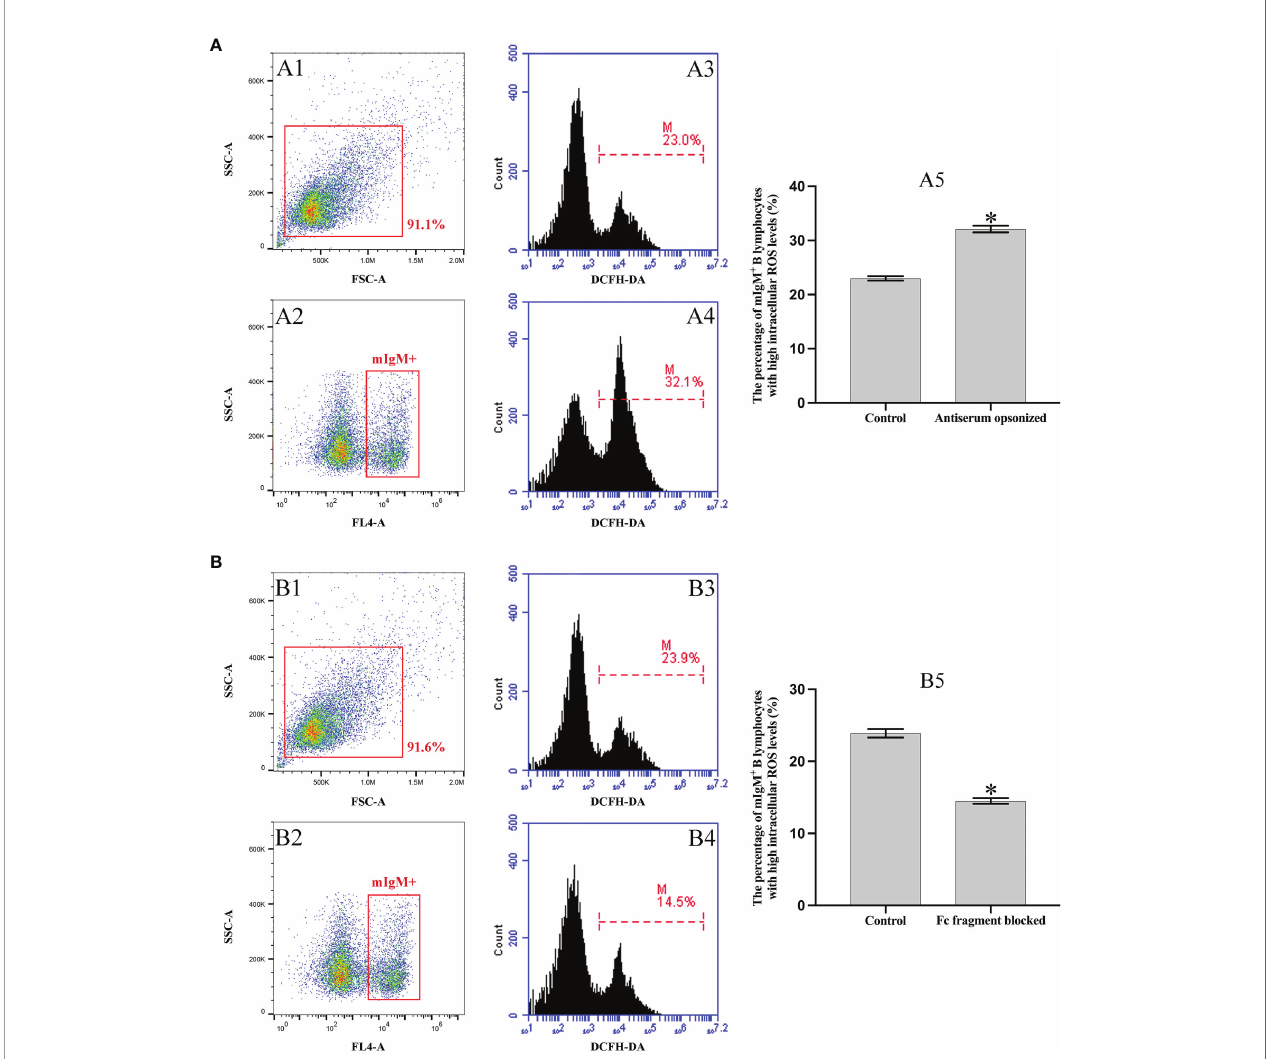
FIGURE 5 | Analysis of intracellular ROS activity of mIgM + B lymphocytes by fl ow cytometry. (A) Incubation with antiserum-opsonized E. tarda . (B) Incubation with Fc blocked antiserum-opsonized E. tarda treated. A1 and B1: FSC/SSC plots of PBLs. A2 and B2: The mIgM + B lymphocytes were gated for analysis. Percentage of mIgM + B lymphocytes with high intracellular ROS levels in healthy fl ounder sera (A3, B3) and antiserum opsonizing groups (A4, B4). A5 and B5: Percentage of mIgM + B lymphocytes with high intracellular ROS levels summarized from the fl uorescence histogram. Error bars indicate the standard deviation of the three biological replicates. The asterisks on the bars represent the statistical difference of the intracellular ROS levels compared to the control group ( p <